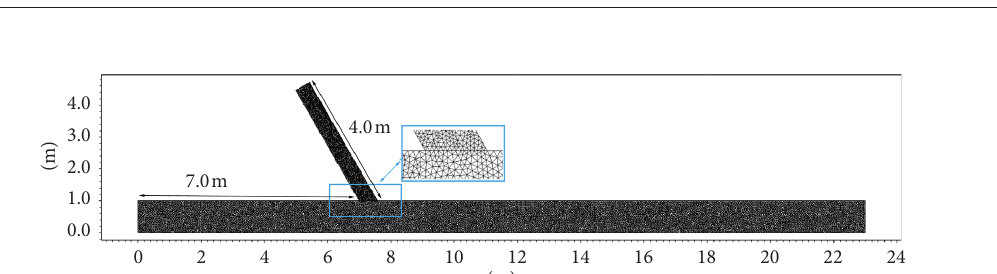
Figure 1: Model grids in the validation domain for the numerical simulation of the Kang flume experiments.